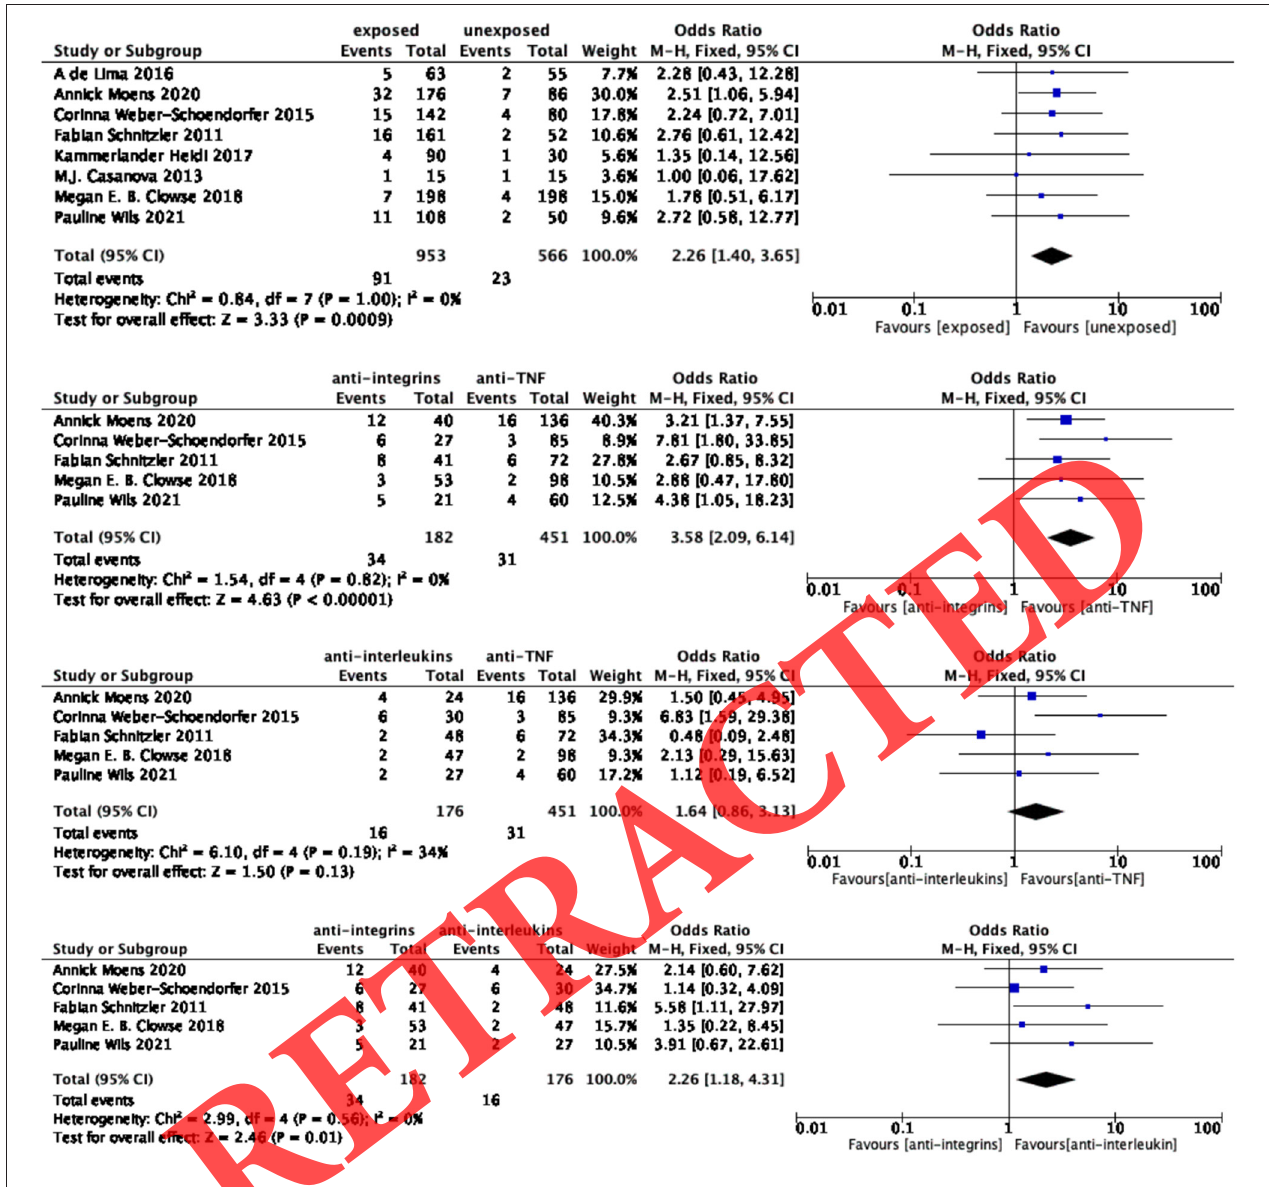
FIGURE 3 | Risk of low birth weight rate in pregnant women treated with biologics for